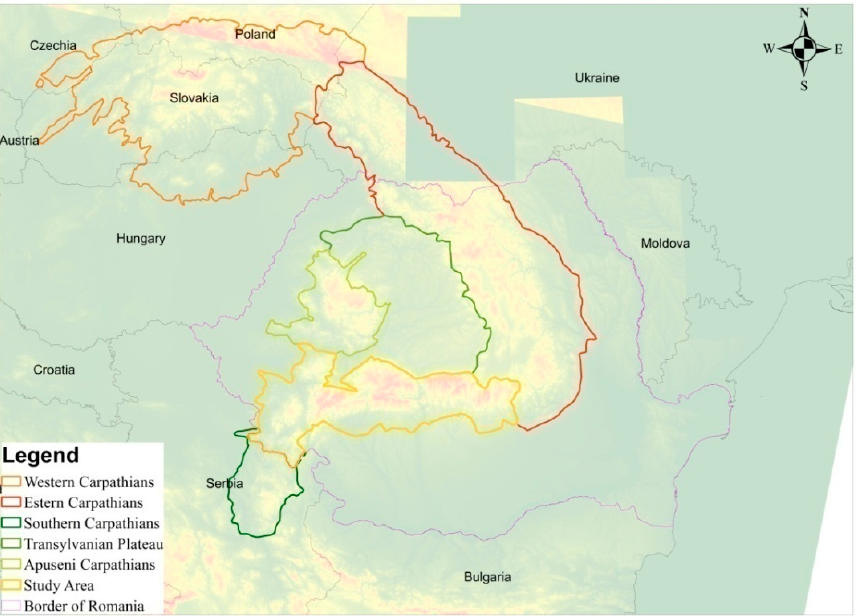
Figure 1. Study area.